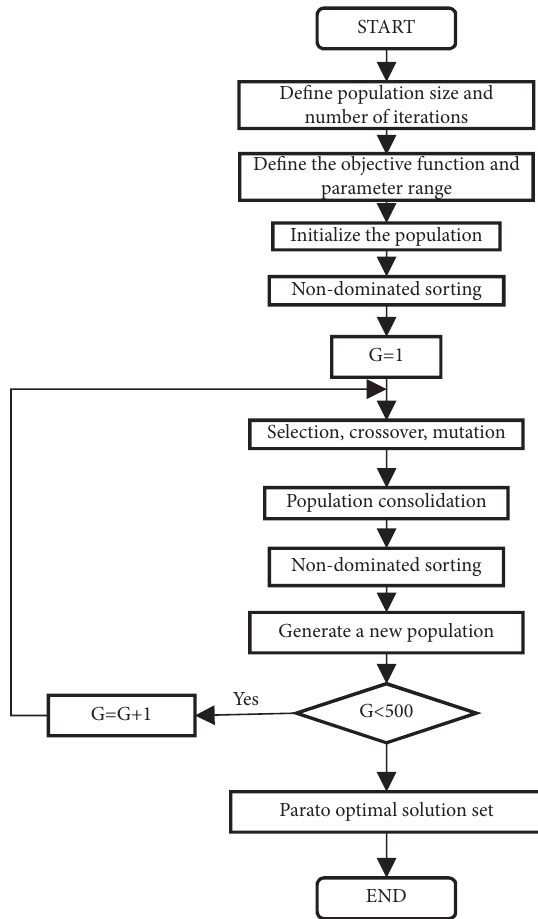
Figure 18: Flow chart of